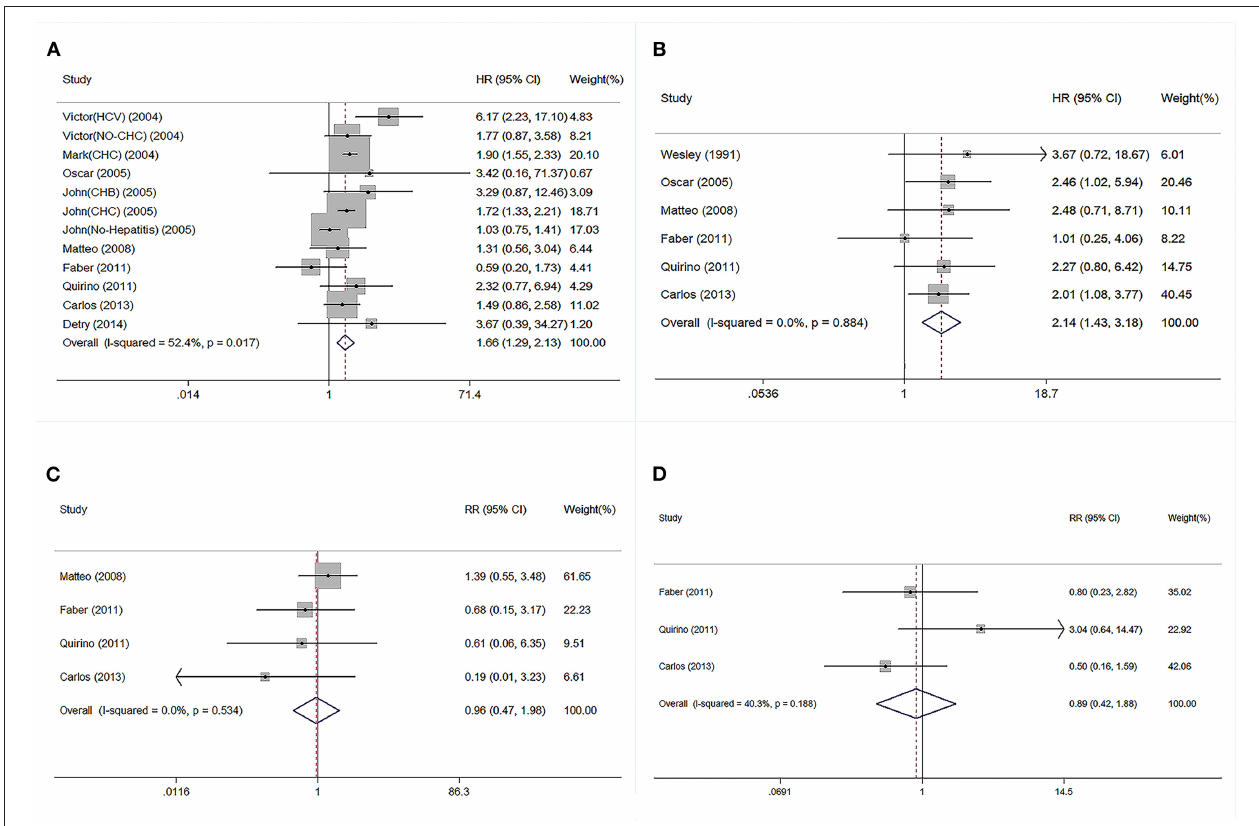
FIGURE 2 | Forest plot on association between donor age and post-transplant outcomes. (A) Pooled RR of graft failure by comparison between elder and younger donor groups. (B) Pooled RR of patient death by comparison between elder and younger donor groups. (C) Pooled RR of PNF by comparison between elder and younger donor group. (D) Pooled RR of re-transplantation by comparison between elder and younger donor groups. PNF, primary non-function; RR, relative risk.